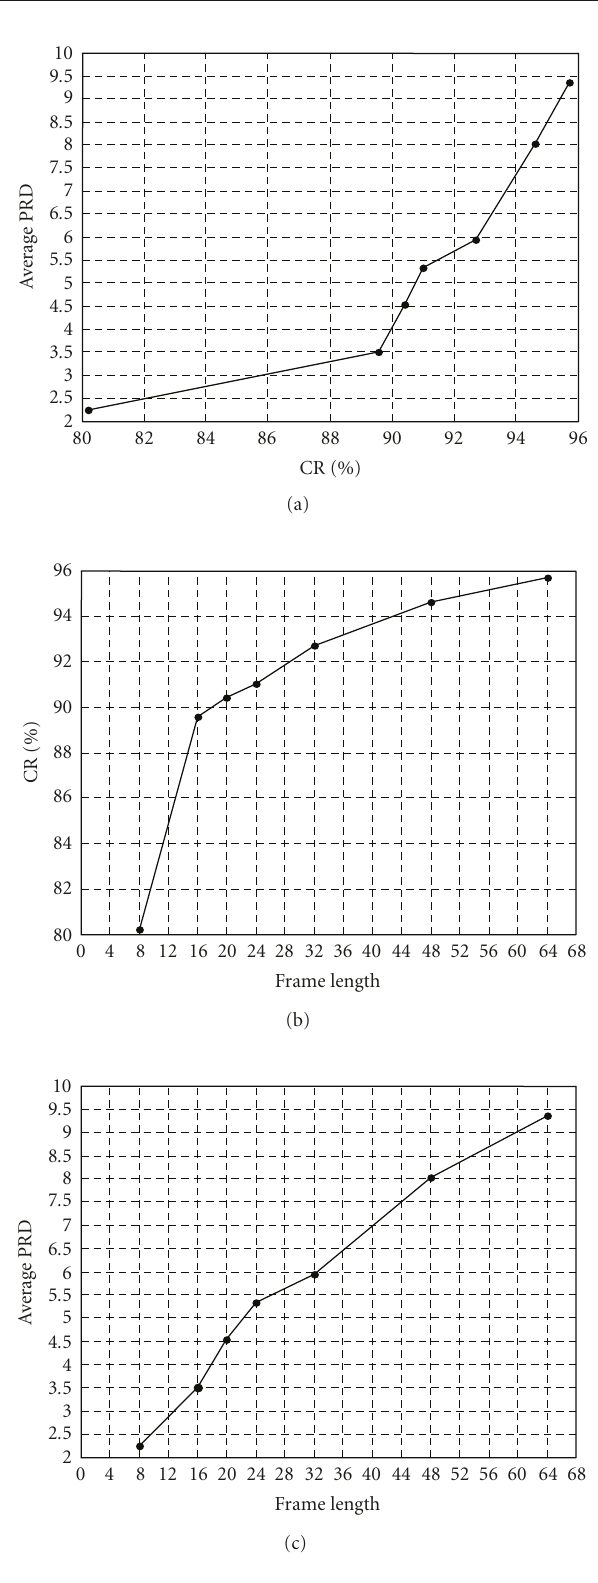
Figure 5: (a) Performance assessment of the new technique: varia- tion of average PRD with respect to CR(%). (b) Performance as- sessment of the new technique: variation of CR(%) with respect to frame length. (c) Performance assessment of the new technique: variation of average PRD with respect to frame length.